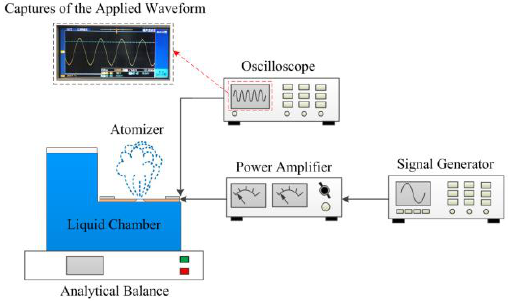
Figure 5. Measurement of the atomization rate and the captures of the applied waveform.